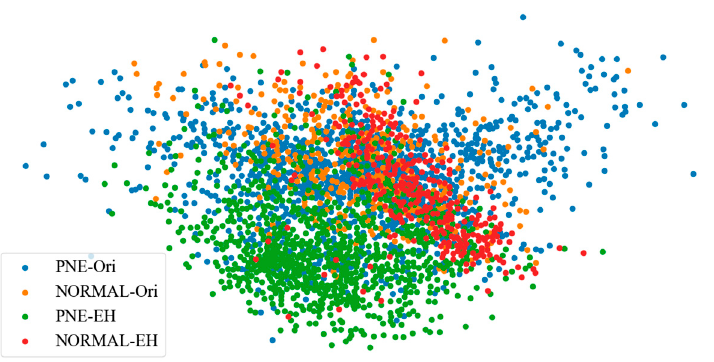
Figure 8. t-SNE of the test set where Ori denotes model using original images and EH denotes the model using enhanced images.